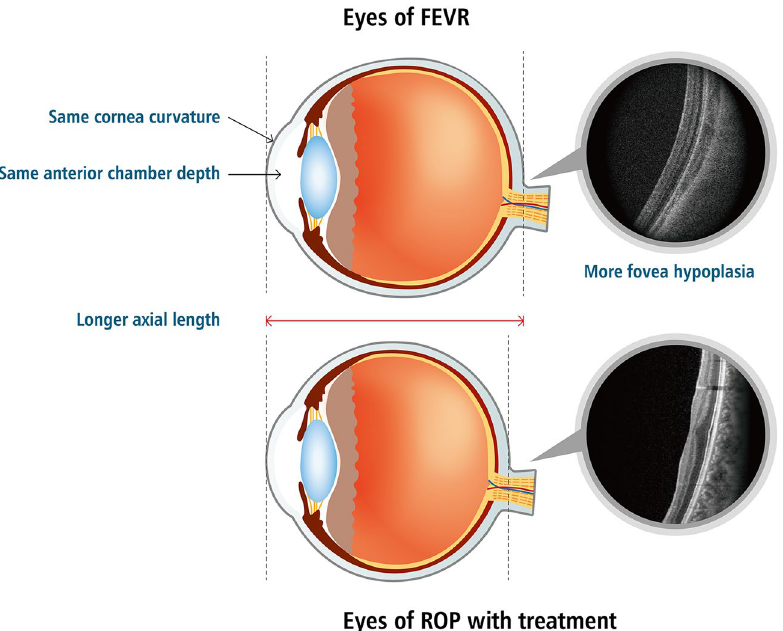
Figure 1. Comparison of optical-component characteristics and fovea status between patients with familial exudative vitreoretinopathy (FEVR) and patients with retinopathy of prematurity (ROP) who had received